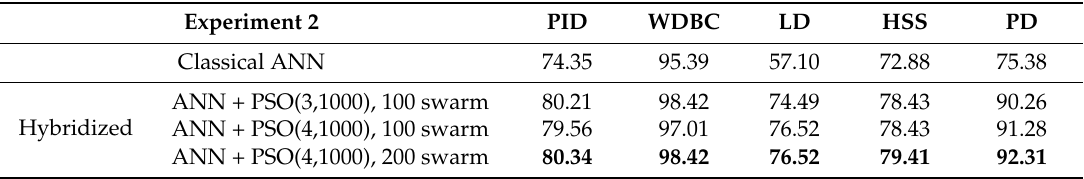
Table 6. Experiment 2 results, 3- and 4-hidden-layer ANN hybridized with PSO algorithm for 1000 iterations.